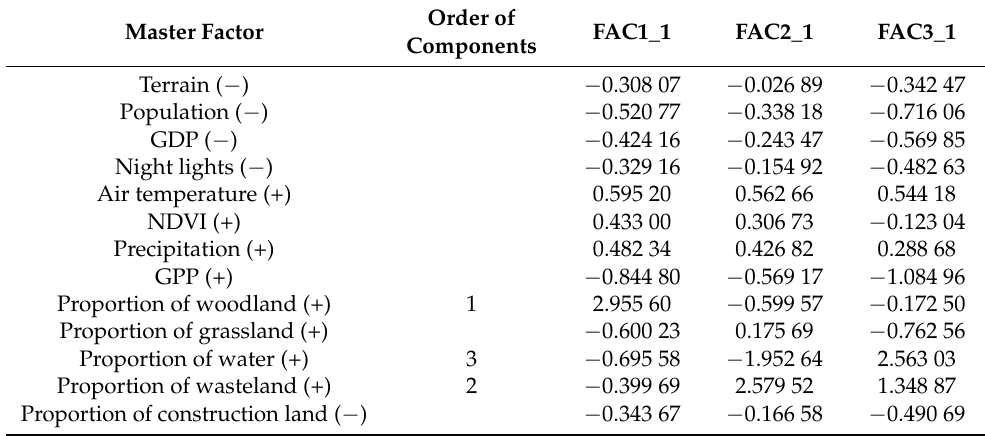
Table 4. Main control factors in 2000.